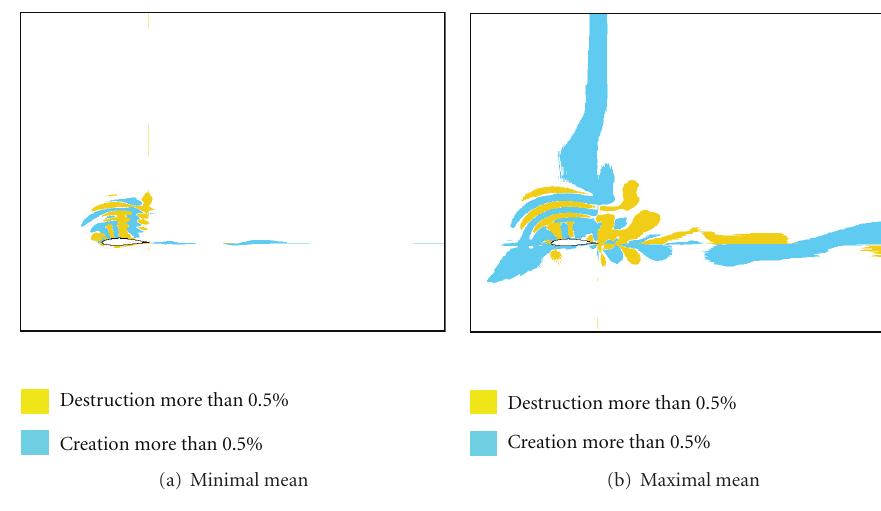
Figure 8: Relative mass imbalance